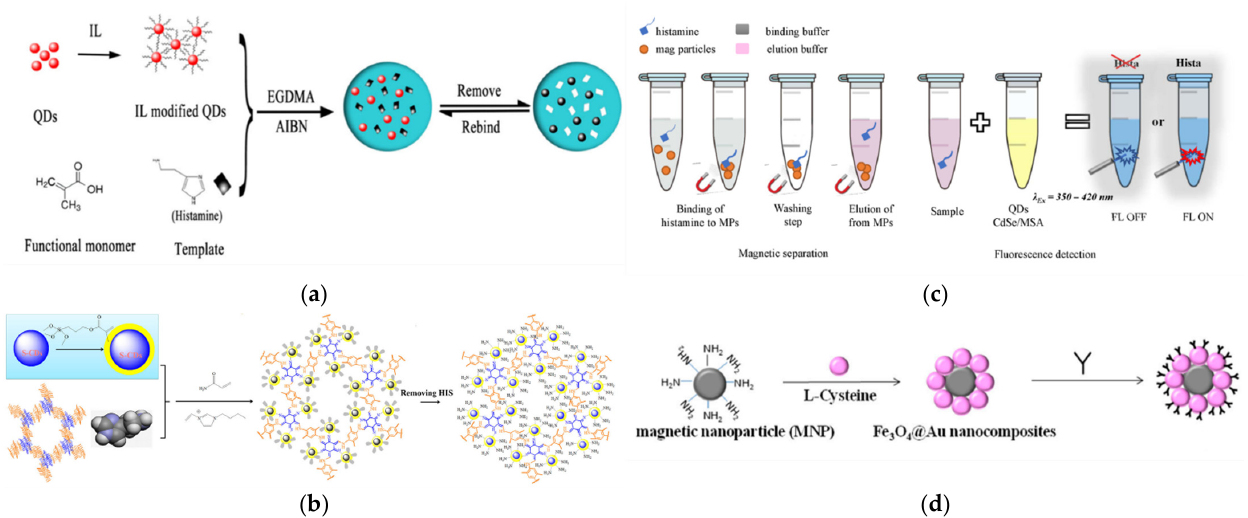
Figure 1. ( a ) Schematic diagram of the preparation of QDs@IL@MIP [53]: ( b ) schematic diagram of the synthesis of a stable covalent-organic-framework fluorescent probe using ionic liquids and S-doped carbon dots [54]; ( c ) CdSe Quantum dots/MSA detection process [63]; ( d ) preparation of